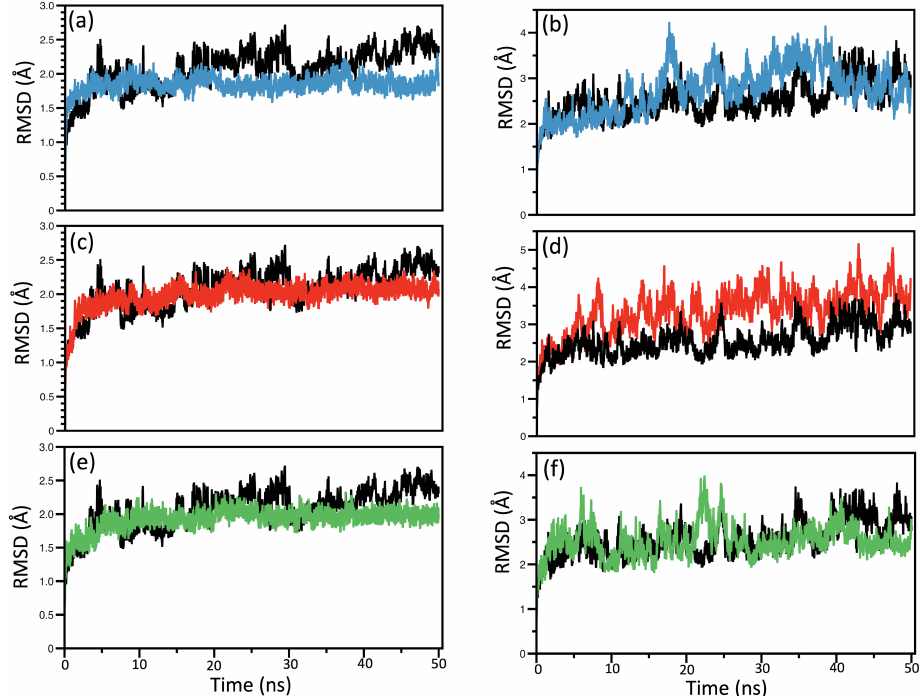
Figure 6. RMSD analysis for NS3 and NS5 receptors. ( a ) Quercetin + NS3, ( b ) Quercetin + NS5, ( c ) Kaempferol + NS3, ( d ) Kaempferol + NS5, ( e ) Chlorogenic acid + NS3, and ( f ) Chlorogenic acid + NS5 by black—unbound protein, blue—Quercetin, rRed—Kaempferol, and green—Chlorogenic